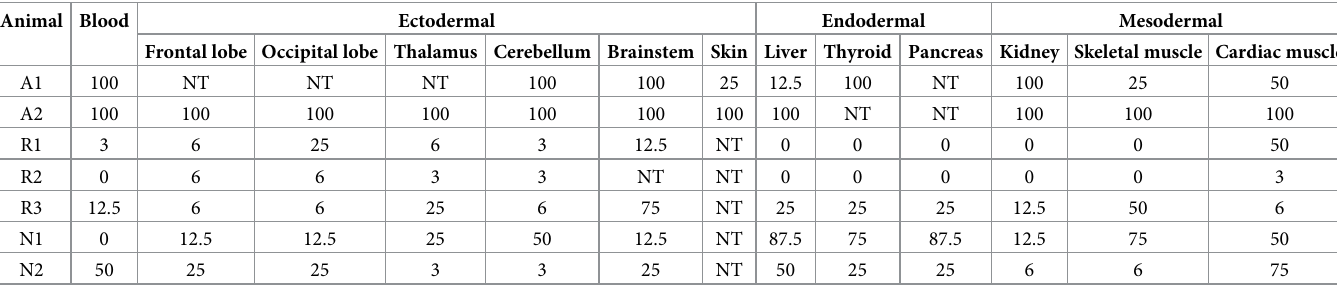
Genotype results for each tissue are presented as the % affected DNA in each sample, as estimated from visual inspection of the banding pattern after gel electrophoresis against serial dilutions of affected:normal DNA in Fig